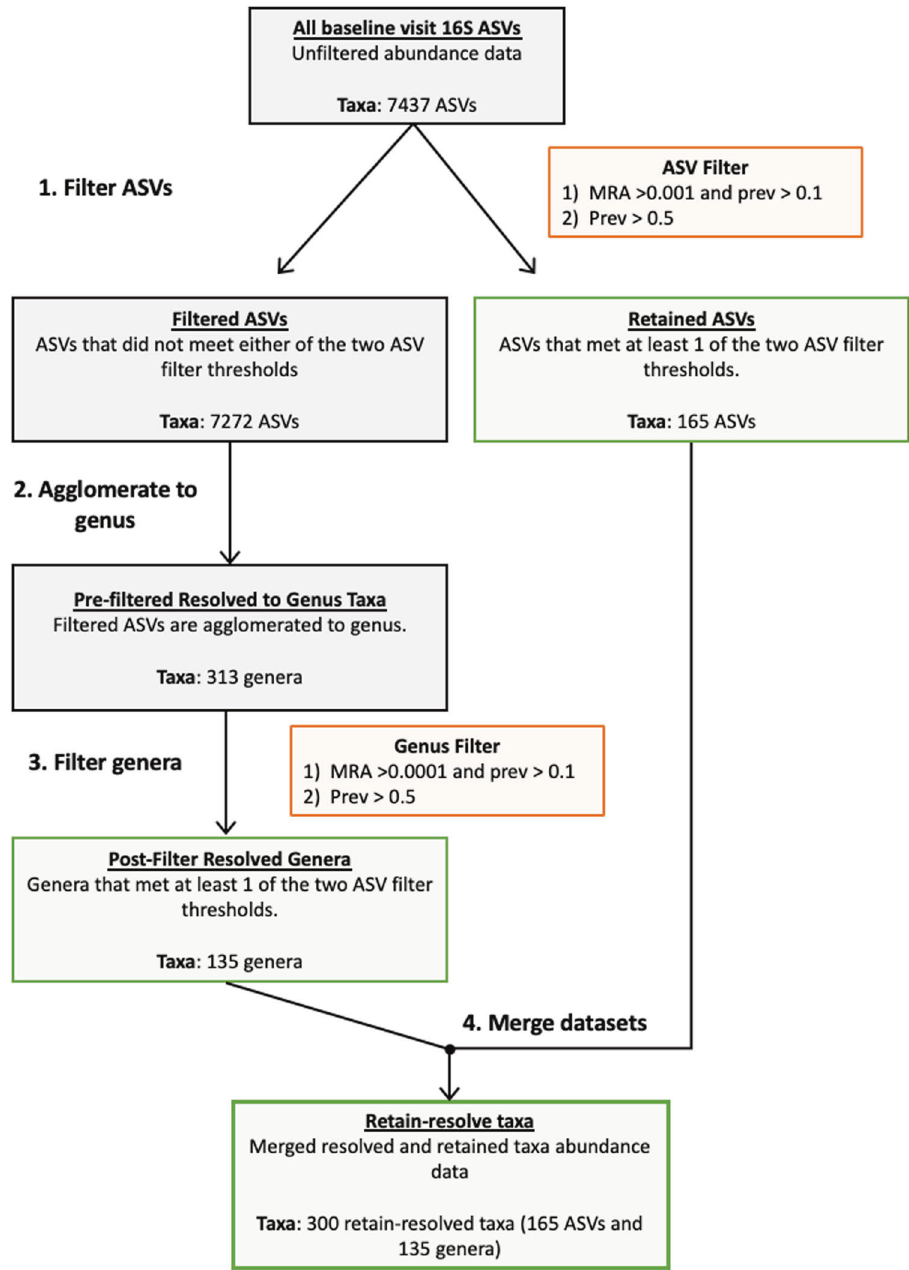
Fig. 1 Retain-resolve agglomeration method. Mean relative abundance (MRA) and prevalence (prev) thresholds were set for fi ltering ASVs and genera. The fi nal 16S taxa dataset contains a mix of ASV-level and genus-level taxa (Supplementary Table S1) that met MRA and prevalence thresholds, or prevalence thresholds